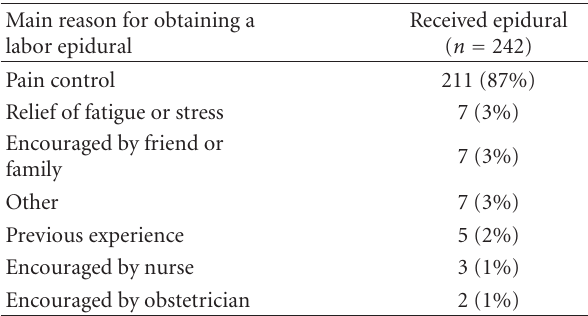
Table 5: Responses to the question. “After coming to the hospital, what was your main reason for actually obtaining an epidural